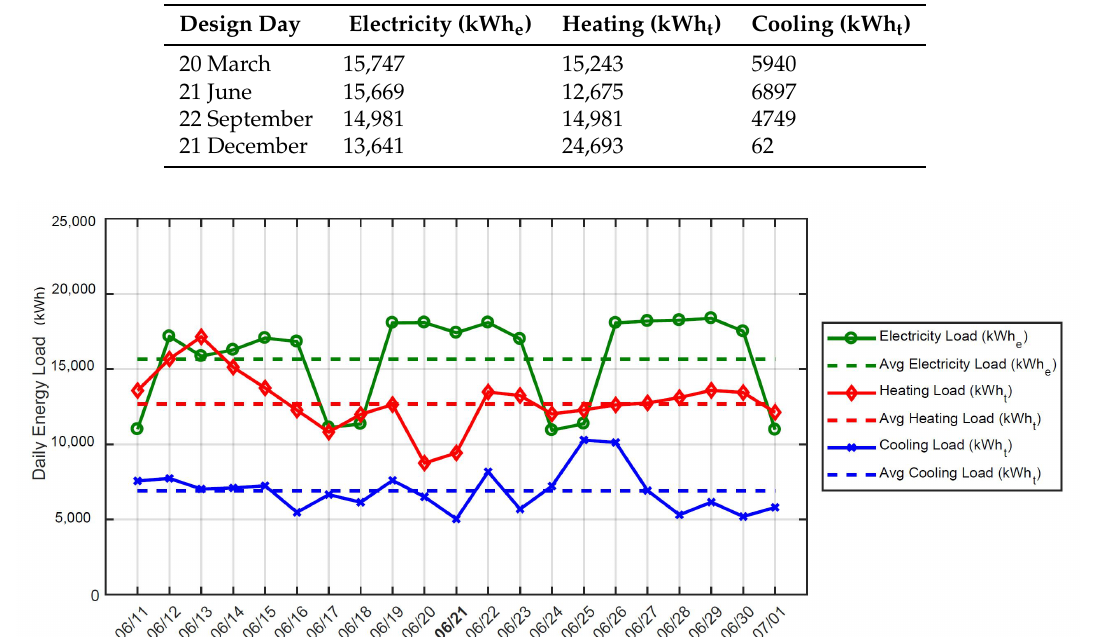
Figure 1. Daily energy loads on 21 June and its neighboring days.